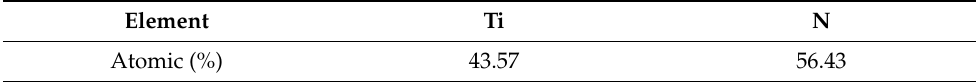
Table 2. Compositions of TiN coating.